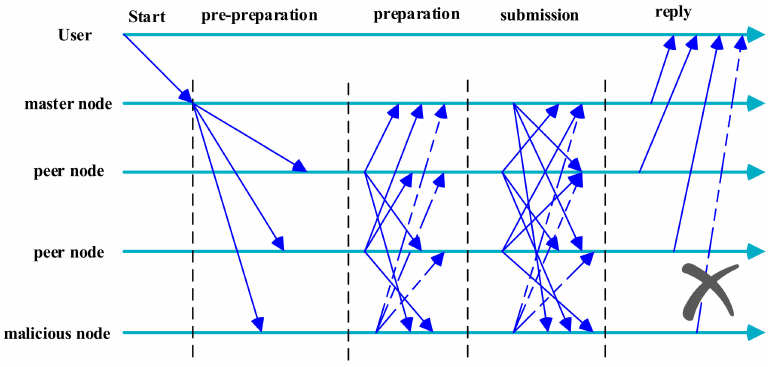
Figure 6. PBFT algorithm